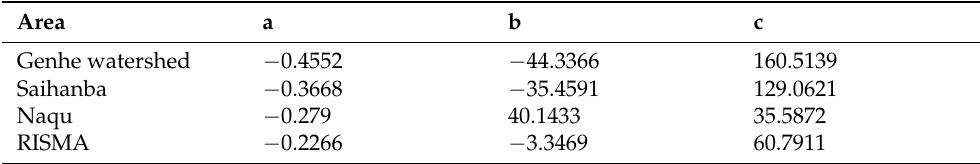
Table 3. The coefficients in Equation (5) over four study areas. Area a b Genhe